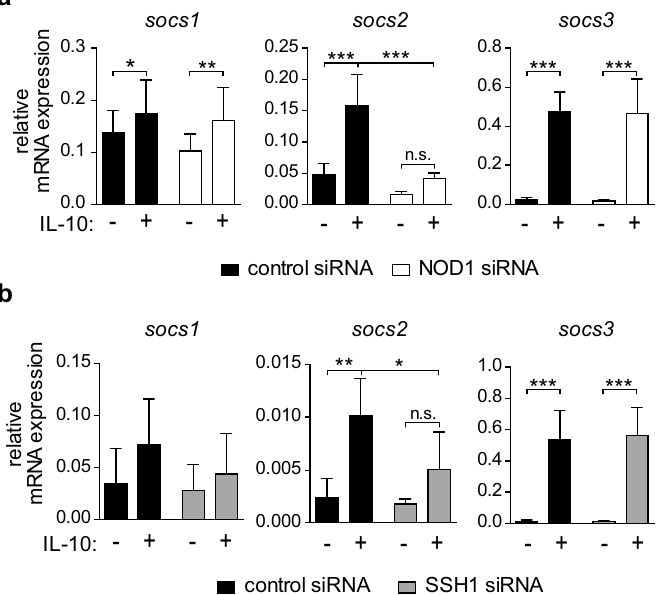
Figure 5. Silencing of NOD1 or SSH1 results in diminished SOCS2 mRNA expression. ( a/b ) iDCs transfected with a control siRNA or with siRNA directed against ( a ) NOD1 or ( b) SSH1 were stimulated with IL-10 (30 ng/ ml) for 2 hours, and socs1 , socs2 and socs3 mRNA expression was analysed by q-RT-PCR. Data represent mean and SD of five independent experiments. For statistical analysis a one-way ANOVA with Tukey’s post hoc test was